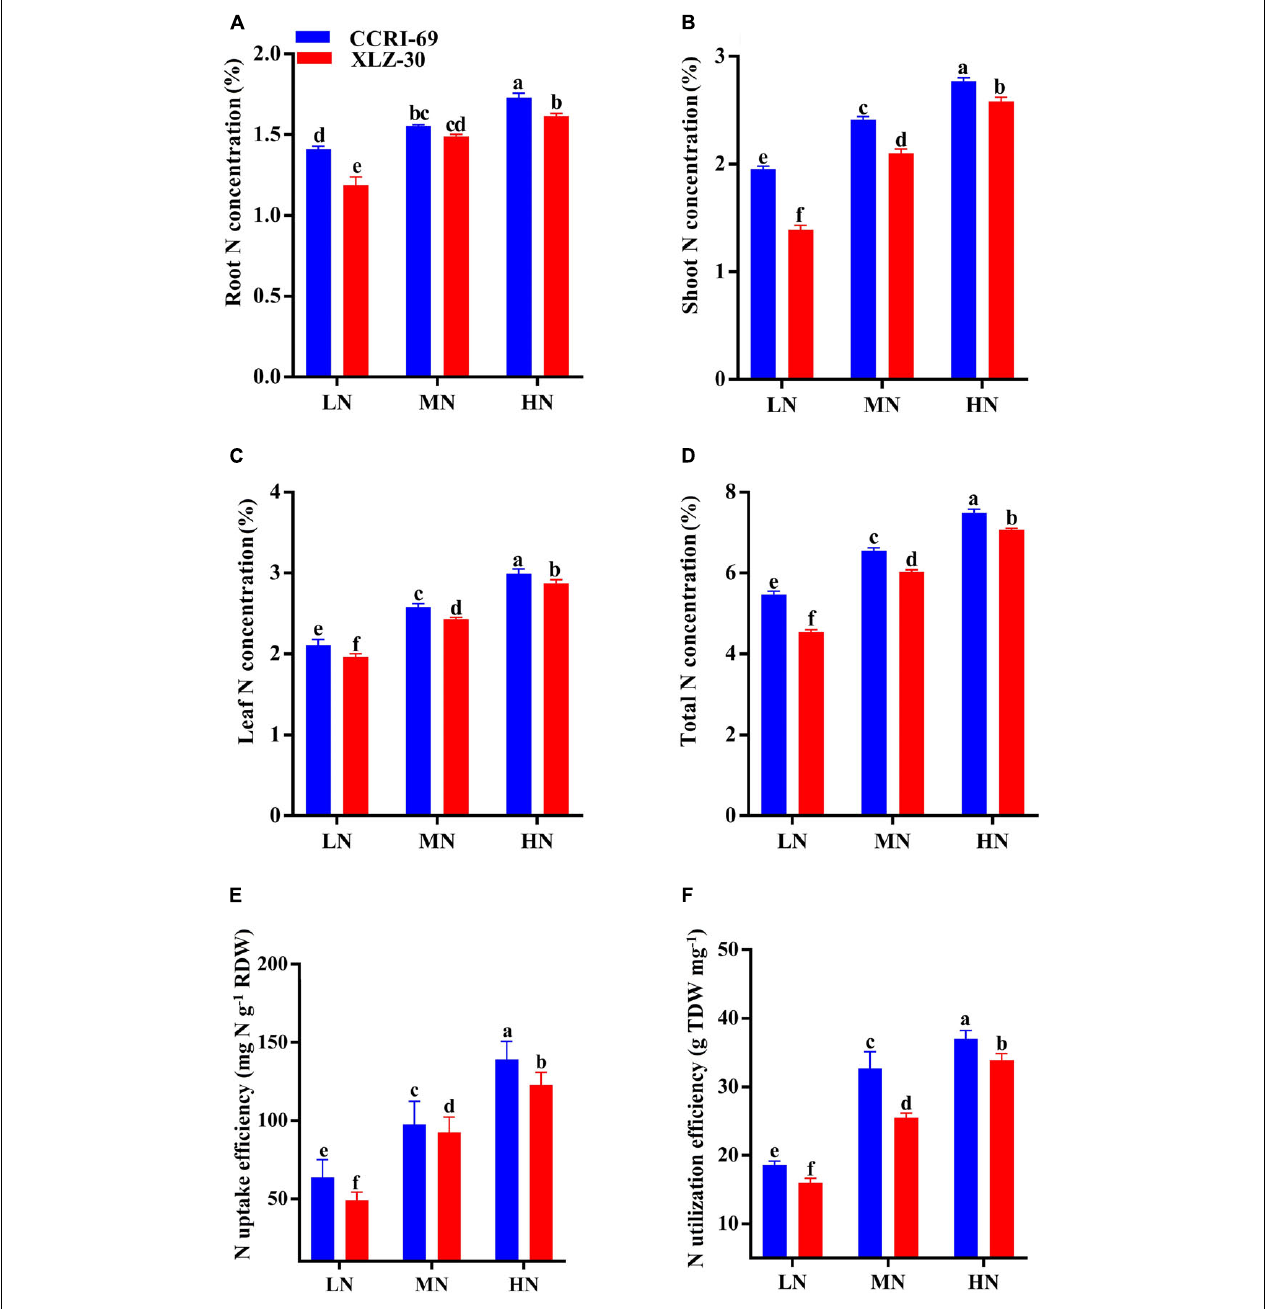
FIGURE 5 | (A–F) Root N concentration (%), shoot N concentration (%), leaf N concentration (%), total plant N concentration (%), NUpE (mg N g − 1 RDW), and NUtE (g TDW mg − 1 ) of CCRI-69 and XLZ-30 in response to low (LN; 0.25 mM), moderate (MN; 2.5 mM), and high (HN; 5 mM) N levels. Error bars with different small letters show significant differences between genotypes under different N levels ( p <